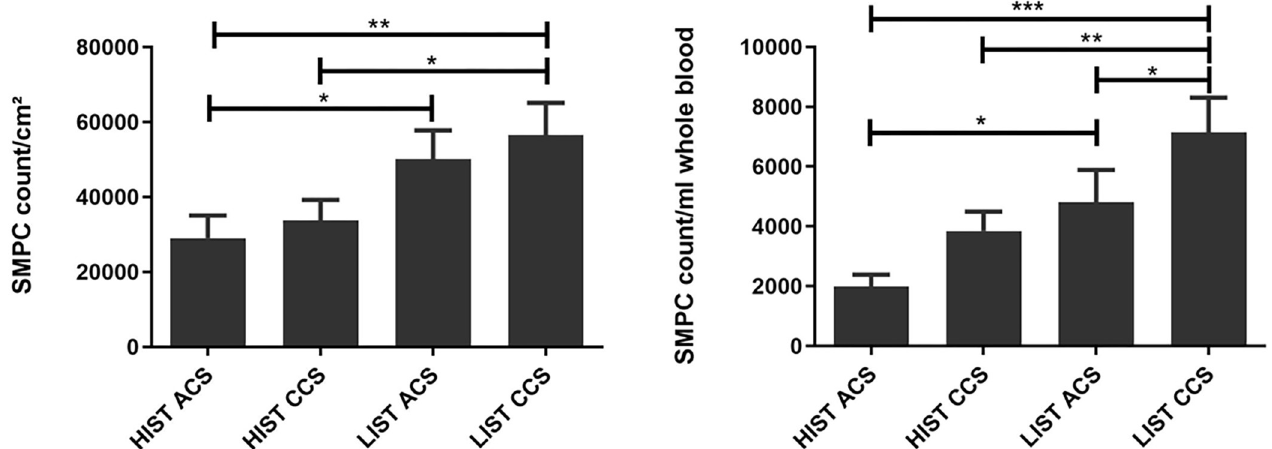
Fig 5. Suppressed SMPC counts in patients under HIST. Relative (left) and absolute (right) SMPC counts revealed significantly lower SMPC levels in patients treated with HIST.